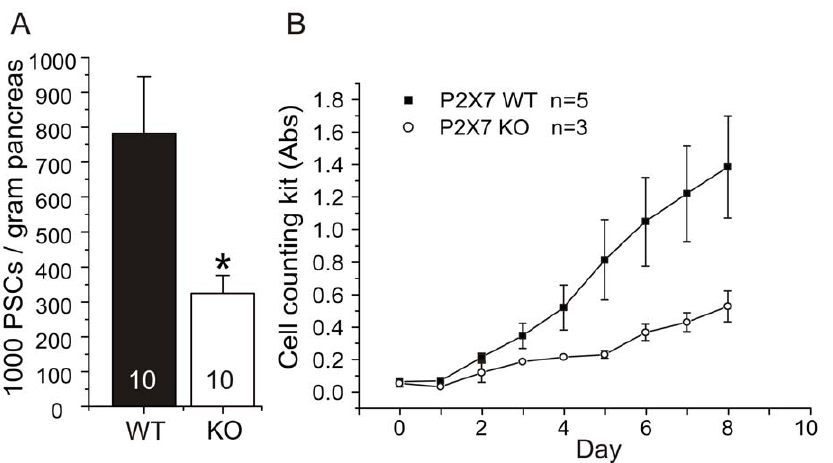
Figure 5. Differences in numbers of isolated and proliferating PSC cells. A. Number of isolated PSCs from pancreas of WT and KO mice (n=10). PSCs were counted immediately after isolation in 5 separate areas of the dish. B. Difference in proliferation of WT and KO PSC following isolation and cell culture, as measured daily with Cell Counting Kit 8. (n=3–5). Significant difference (P , 0.05) between WT and KO (*) is indicated.